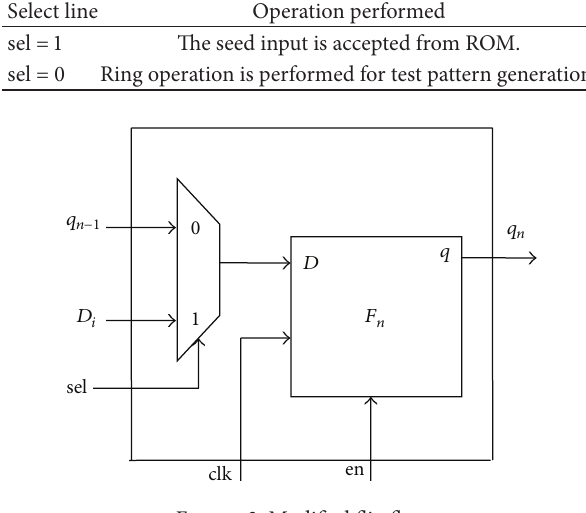
Figure 3: Modified flip flop.